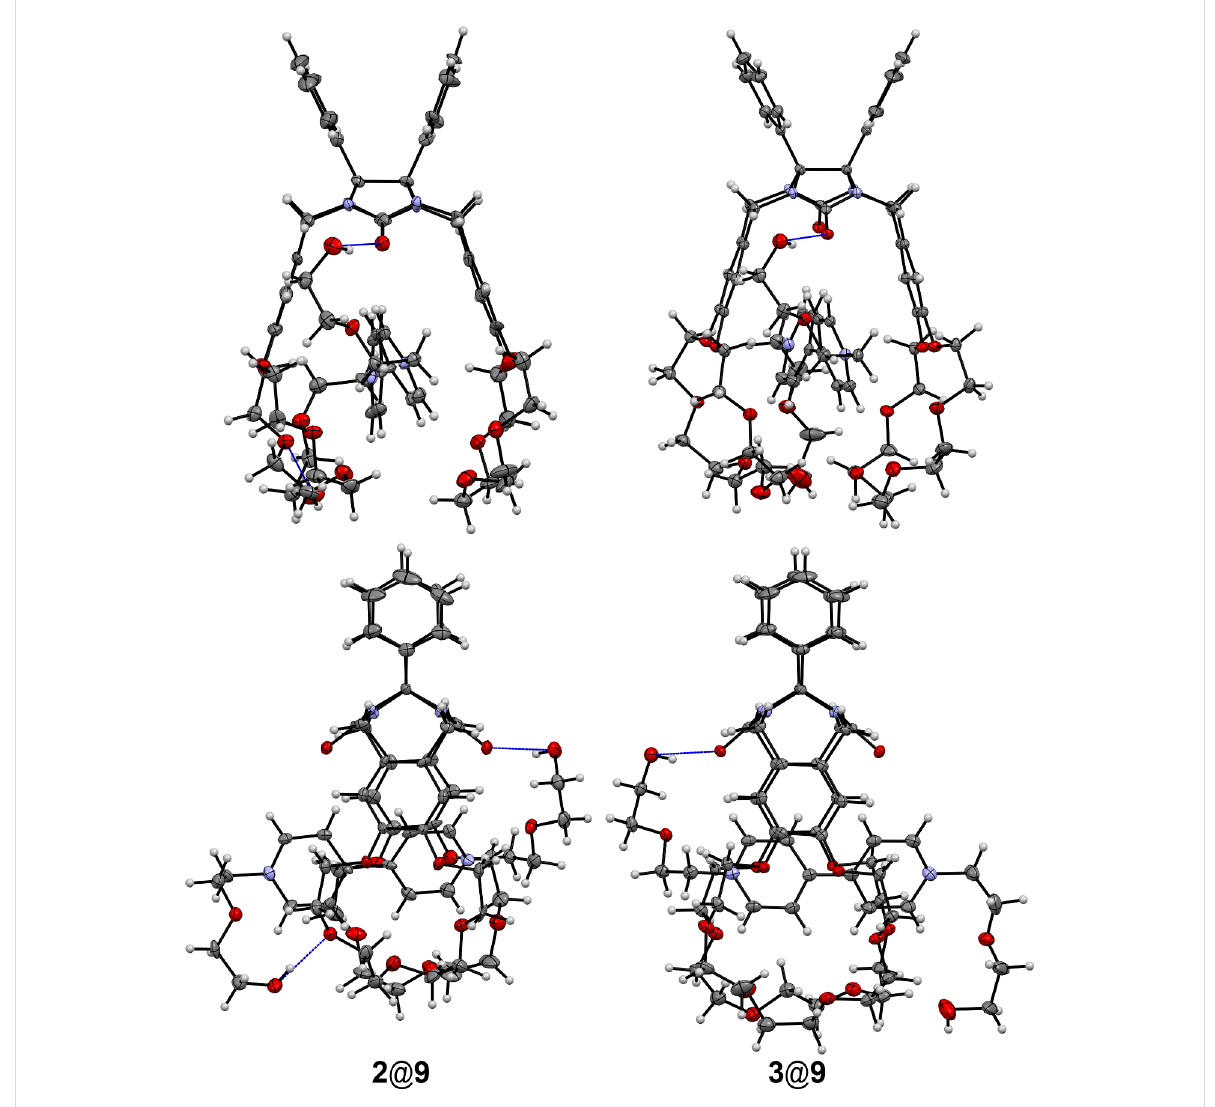
Figure 9: Molecular structures of complexes 2 @ 9 and 3 @ 9 . The hydrogen bonds are represented by blue lines. Anions and solvate molecules are omitted for clarity.